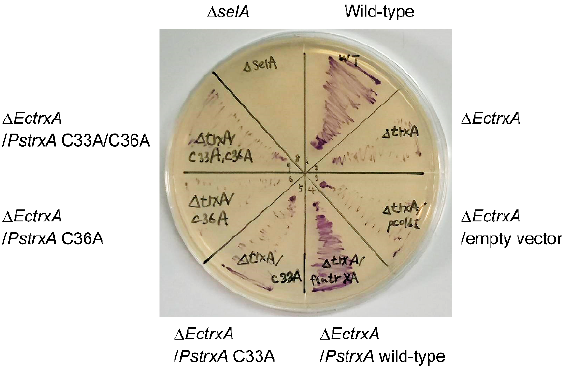
Figure 4. Whole cell FDH assay using E. coli . E. coli cells of the wild type, a SelA gene disruptant ( Δ selA ), and EcTrxA disruptants ( Δ EctrxA ) complemented without (none or empty vector) or with PsTrxA variants (wild type, C33A, C36A, or C33A/C36A) were anaerobically cultured on Luria– Bertani medium containing 0.5% glucose, then FDH activity was assayed using benzyl viologen.